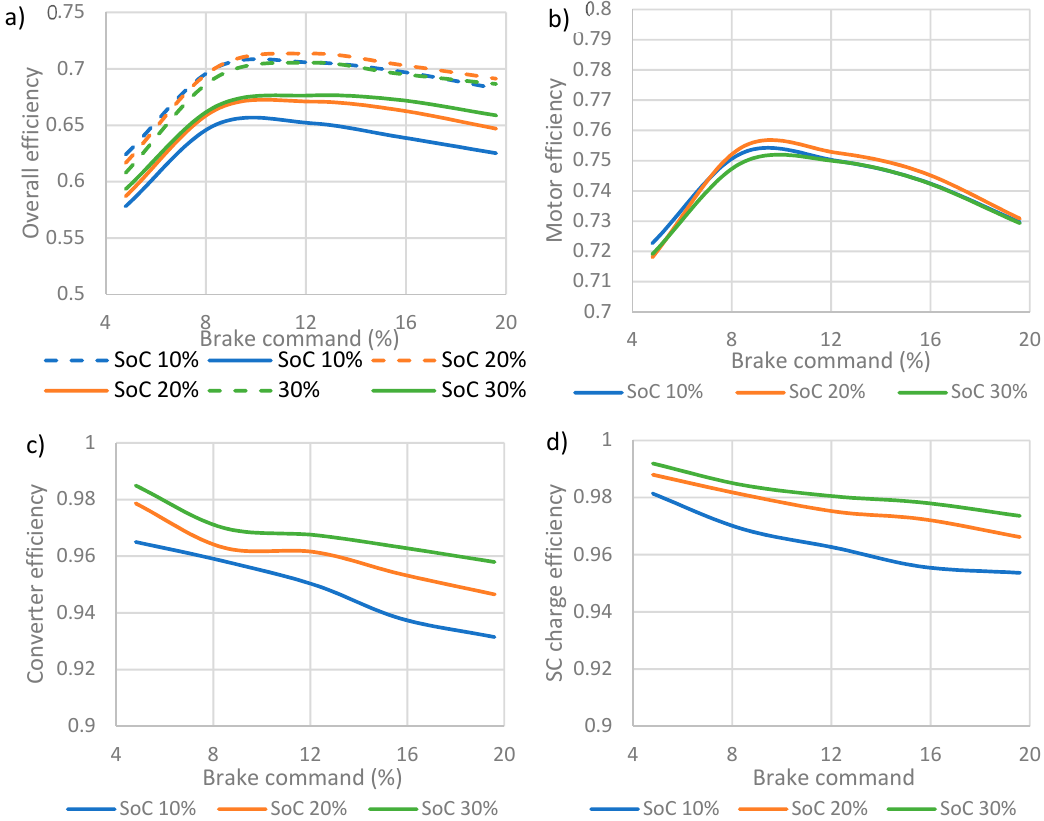
Figure 8. ( a ) Overall efficiency of transferring the energy in the flywheel into the supercapacitor (the dashed line represents the efficiency if the rated capacitance of the SC is used, the solid line uses the calculated capacitance); ( b ) motor efficiency; ( c ) converter efficiency; ( d ) SC efficiency.